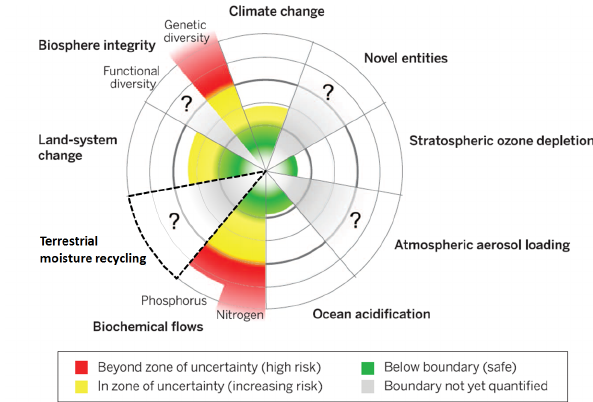
Figure 3. An example of how a water-related planetary boundary could be explicit with regard to both the mechanism of interest and our lack of understanding it; modified from Steffen et al. (2015), with permission from